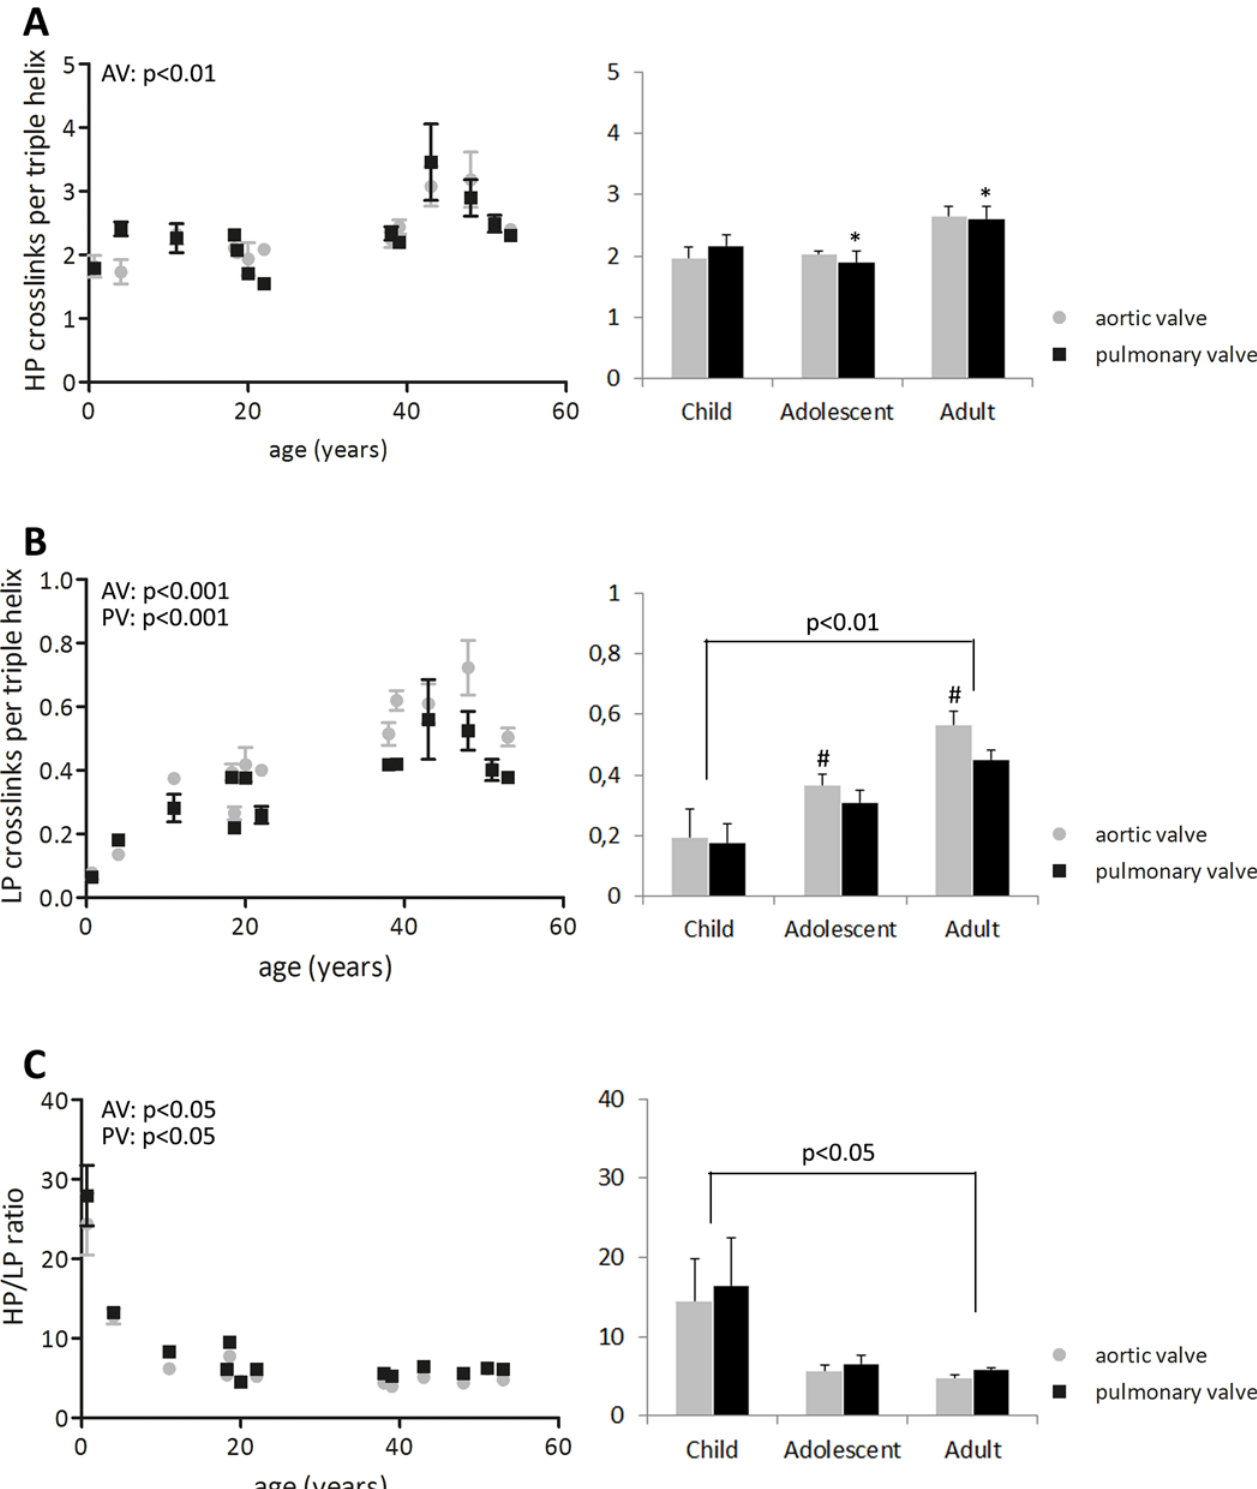
Fig 5. Changes in collagen HP, LP cross-links, and the HP-to-LP ratio. Changes in collagen HP (A), LP cross-links (B), and the HP-to-LP ratio (C) in μ g/ mg dry weight (left side: all data points used for correlation analysis with age; right side: grouped data). HP cross-links density increases with age in the aortic valve. In the pulmonary valve, the HP cross-link density increases from adolescent to adult age. LP cross-link density increases with age in both valves. Only